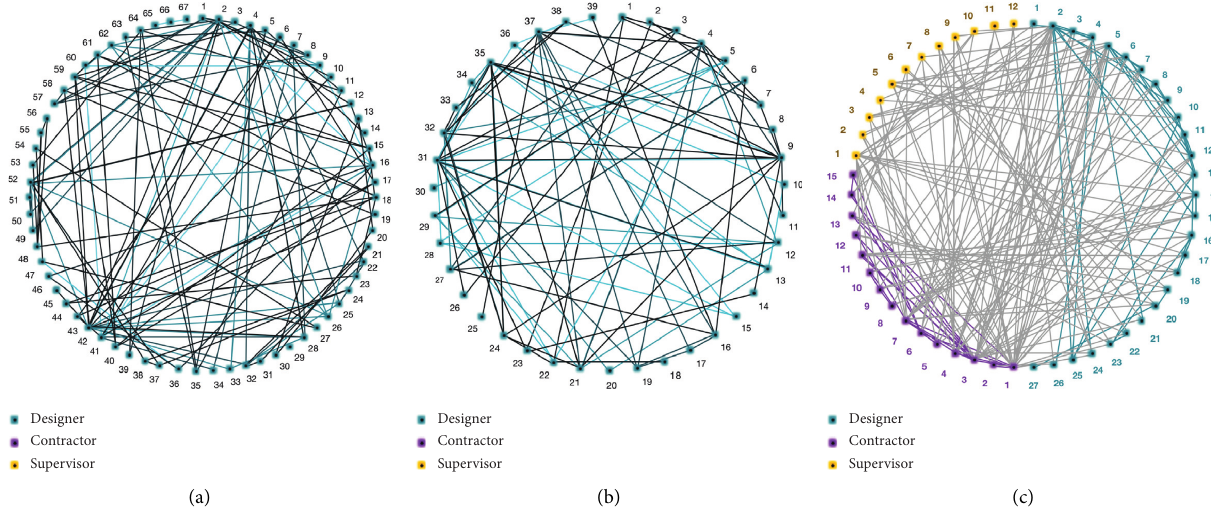
Figure 3: The construction of social network. (a) Map of the business network among designers referred to statistics of the skyscraper cases from 1996 to 2015. The color of the straight line from light to dark indicates the year from early to late. (b) Map of the business network among contractors referred to statistics of the skyscraper cases from 1996 to 2015. The color of the straight line from light to dark indicates the year from early to late. (c) Map of the business network among designers, contractors, and supervisor referred to statistics of the skyscraper cases in 2004.